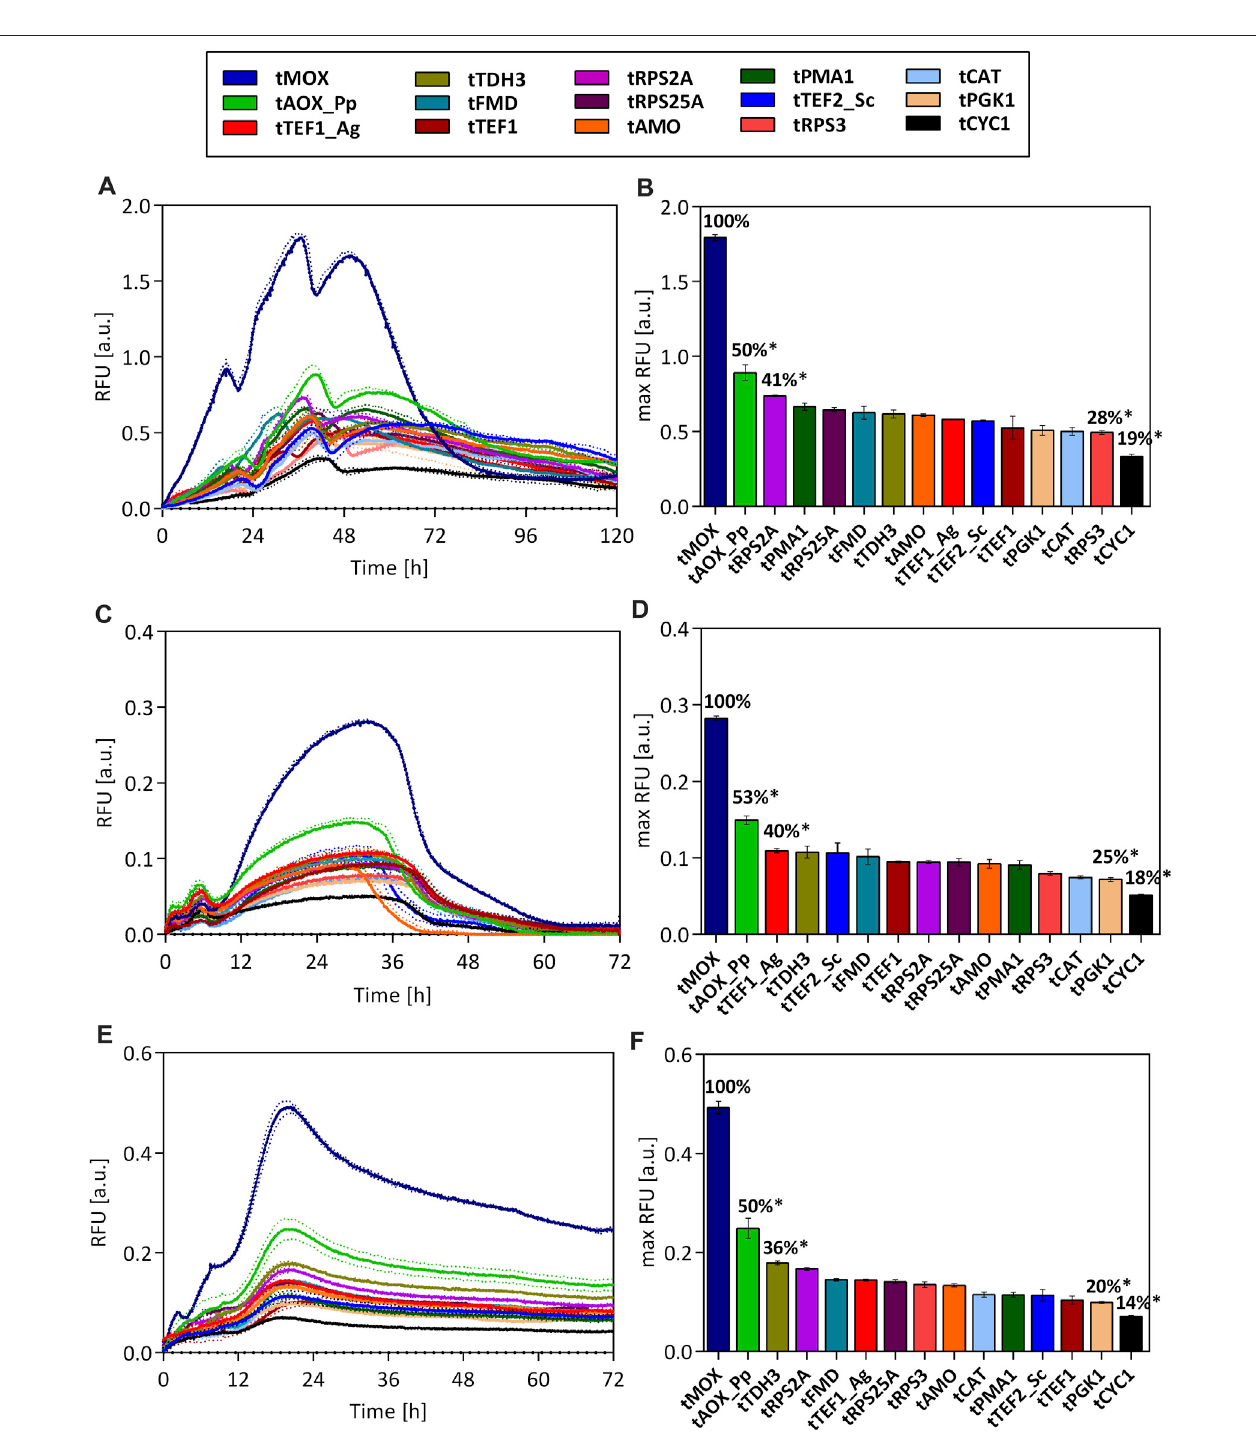
FIGURE 3 | GFP fl uorescence throughout the cultivation of O. polymorpha strains. Expression of an ubiM-GFP gene under the control of the pCAT promoter and varyingterminatorsonmethanol (A) ,glucose (C) ,andglycerol (E) ascarbonsource.MaximalGFP fl uorescenceforeachstrainonmethanol (B) ,glucose (D) ,andglycerol (F) . All measured fl uorescence values were normalized to the biomass density (scattered light value) in the culture. Dotted lines (A,C,E) and error bars (B,D,F) represent thestandarddeviationfromthreebiologicalreplicates.Statisticalsigni fi cance(indicatedwith*when p < 0.05)wastestedwithanunpaired,two-tailed t -testbetween the max RFU of the various terminator strains and the highest max RFU of the tMOX strain on each carbon source (tMOX 100%) Supplementary Table S7 .